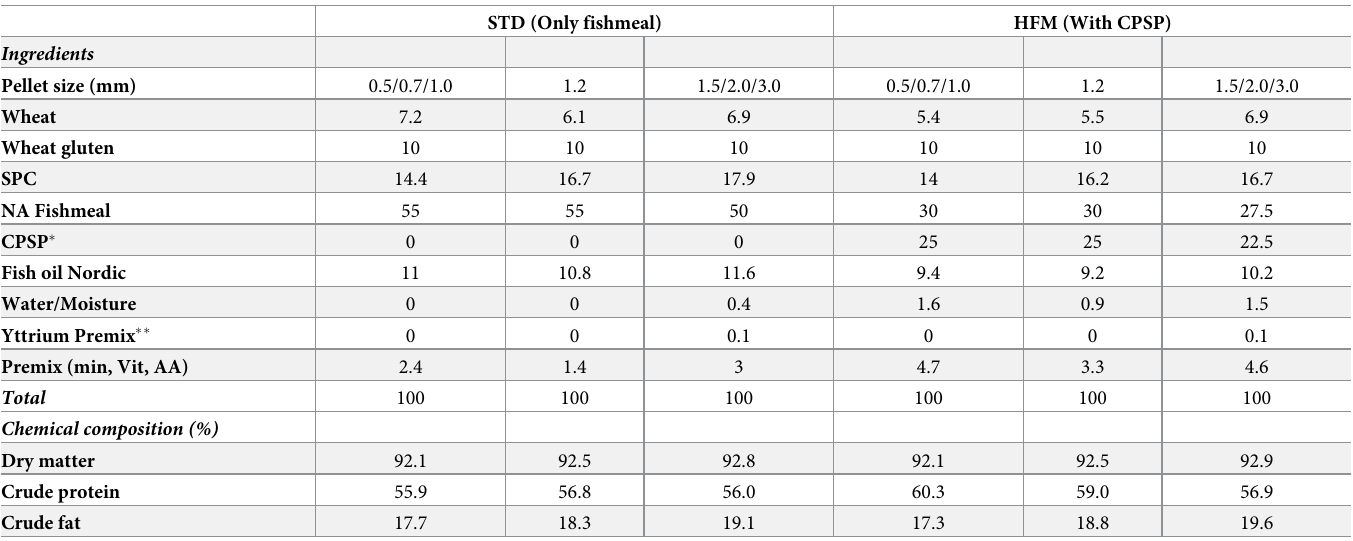
Table 2. Formulation and composition of the STD and HFM diets (G.Reisen, Skretting AS). STD (Only fishmeal) HFM (With